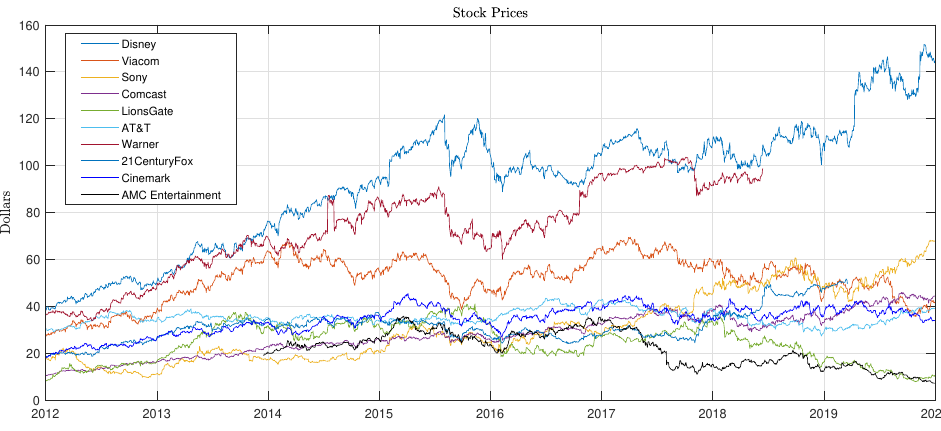
Figure 15. Stock prices for the public companies involved in the U.S. Film